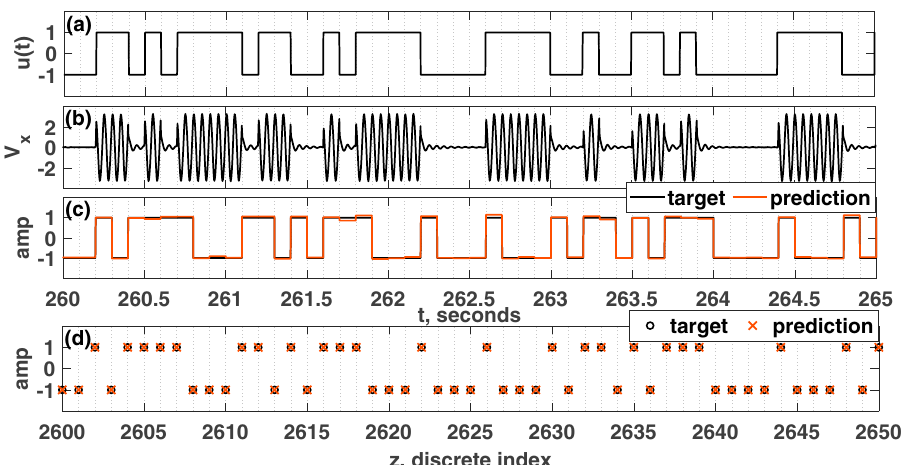
Figure 6. ( a ) Input voltage signal, V u . ( b ) Time history of V x . ( c ) XOR target signal, M , and the prediction. ( d ) Discretized prediction. The calculated information metric is R = 1.0 . For the experimental results depicted here, the parameters were set such that: V µ = 5 volts, A = 0.5 volts, � = 40 π rad/s, V ω 0 = 40 π volts, T p =